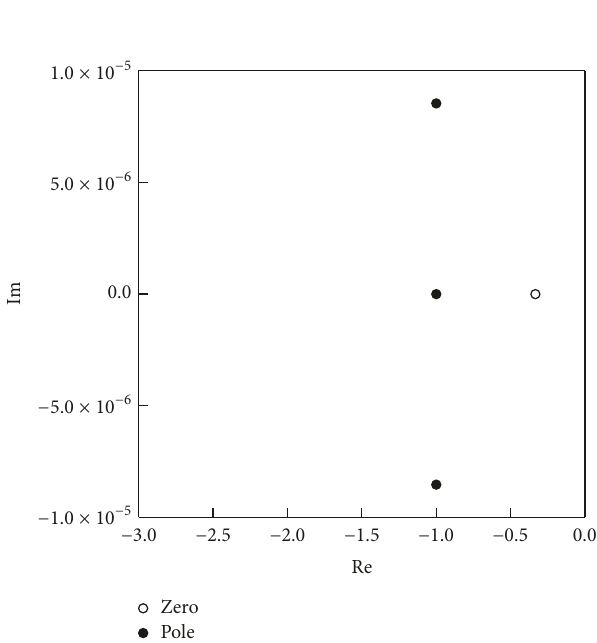
Figure 9: Zero-pole plot ( 𝛼 = 2, 𝛽 = 1 ).